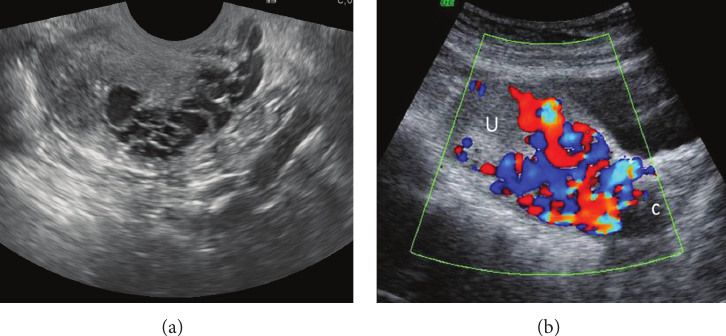
Figure 5: Uterine vascular malformation presenting with recurrent vaginal bleeding following successful treatment of invasive mole. Sagittal TVS image (a) of the uterus reveals multiple tortuous, serpiginous anechoic spaces in the myometrium. Color Doppler TAS (b) reveals a mosaic pattern of color signal within the spaces. U = uterus; C = cervix. No evidence of any myometrial mass is seen to suggest a residual GTN.